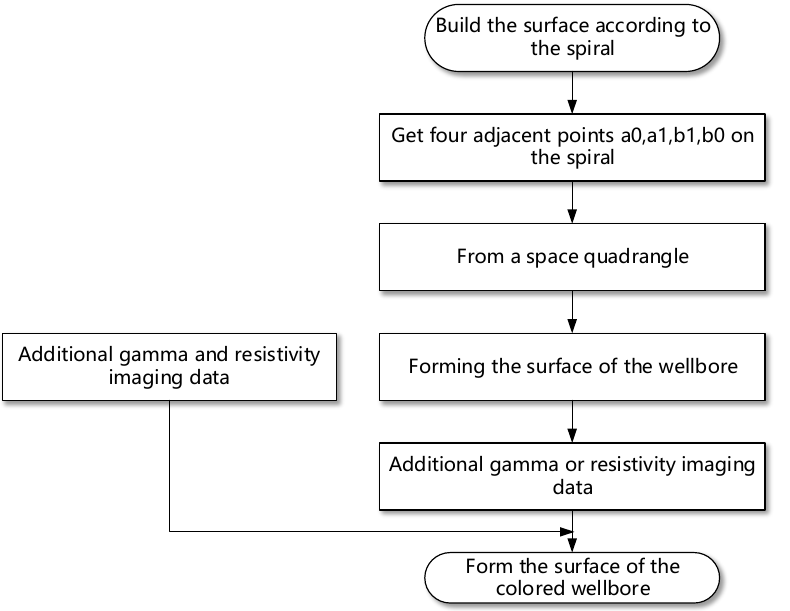
Figure 8. Flow chart of surface reconstruction and attach attributes.